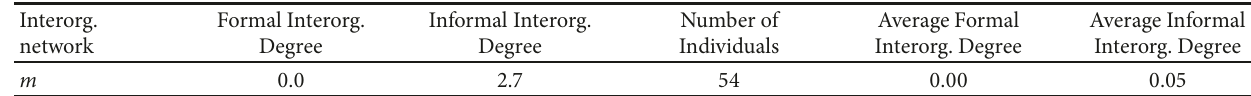
Table 9: Interorganisational